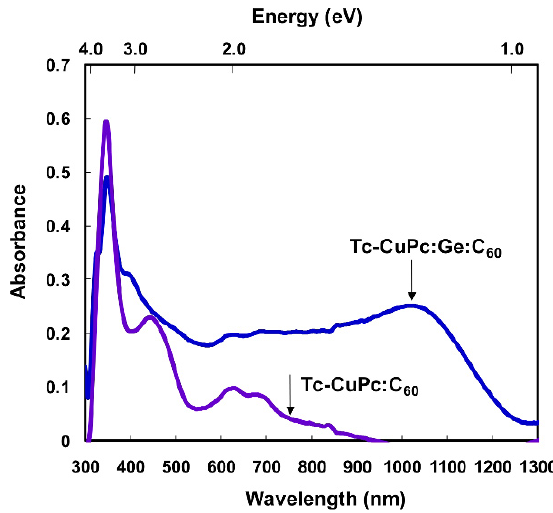
Figure 3. AbsorbancespectrumofTc-CuPc:Ge:C 60 andTc-CuPc:C 60 bulk heterojunction structure.